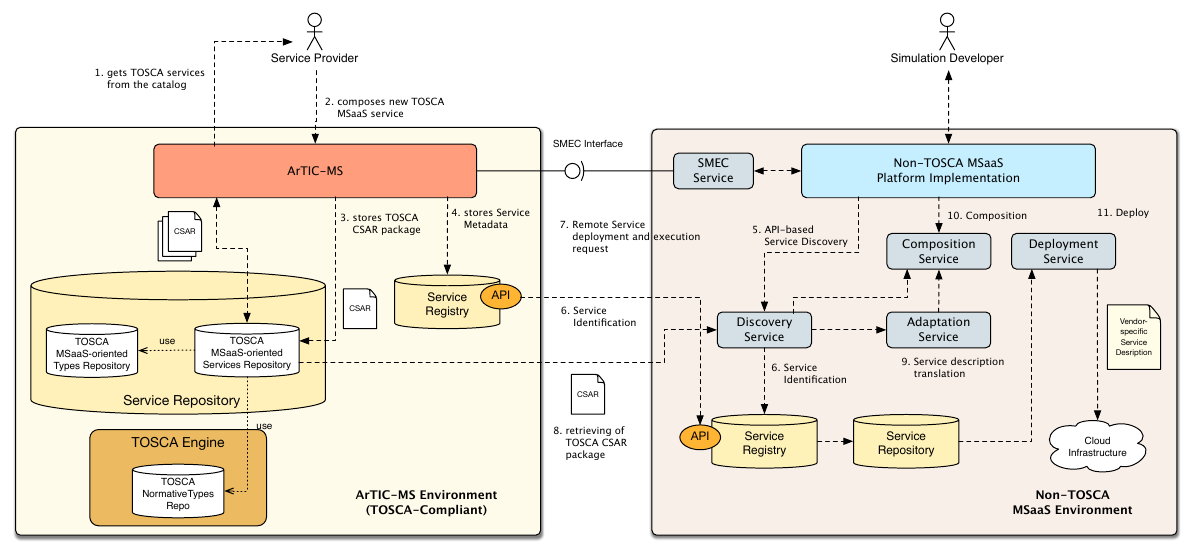
Figure 11. Federation of heterogeneous MSaaS